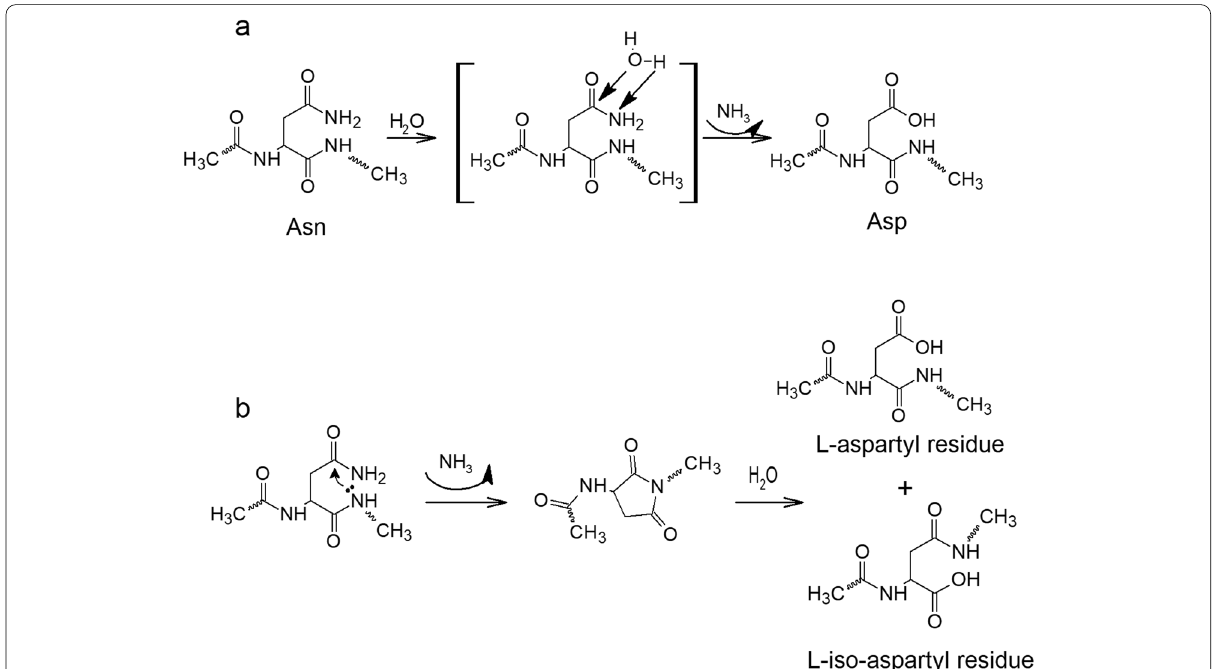
Fig. 2 Mechanisms for the deamidation of the asparagine residue via ( a ) direct hydrolysis and ( b ) formation of a succinimide intermediate [16, 28,